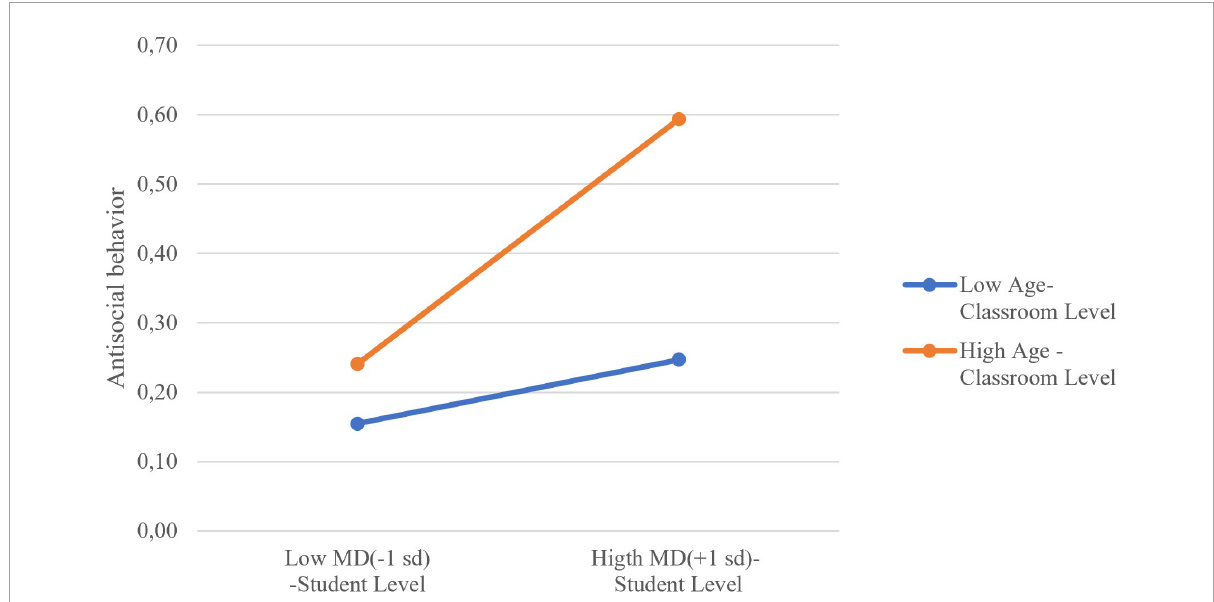
FIGURE2 Cross-level interaction effect of individual moral disengagement with classroom mean age on antisocial behaviors.